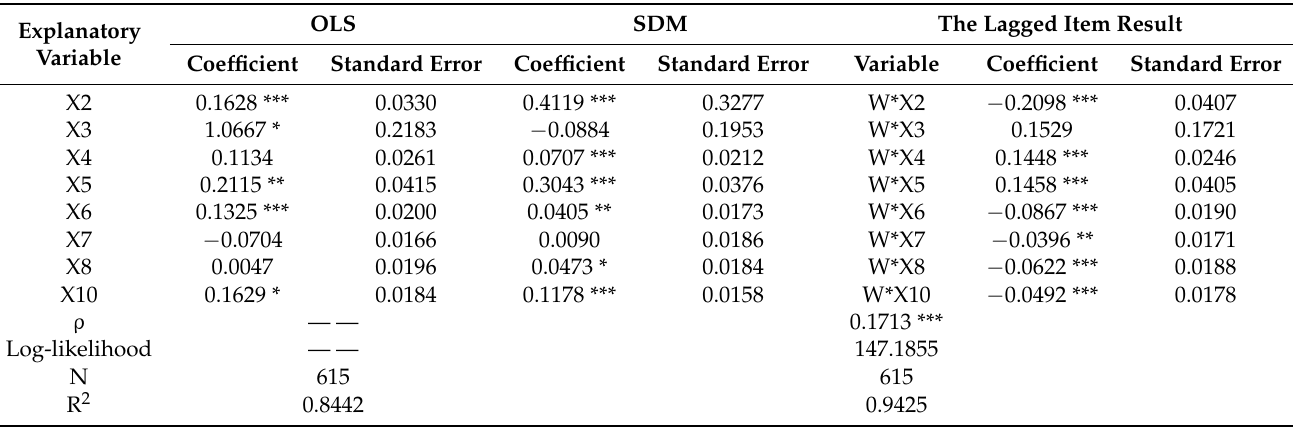
Table 9. The regression results of the ordinary panel model and spatial Durbin